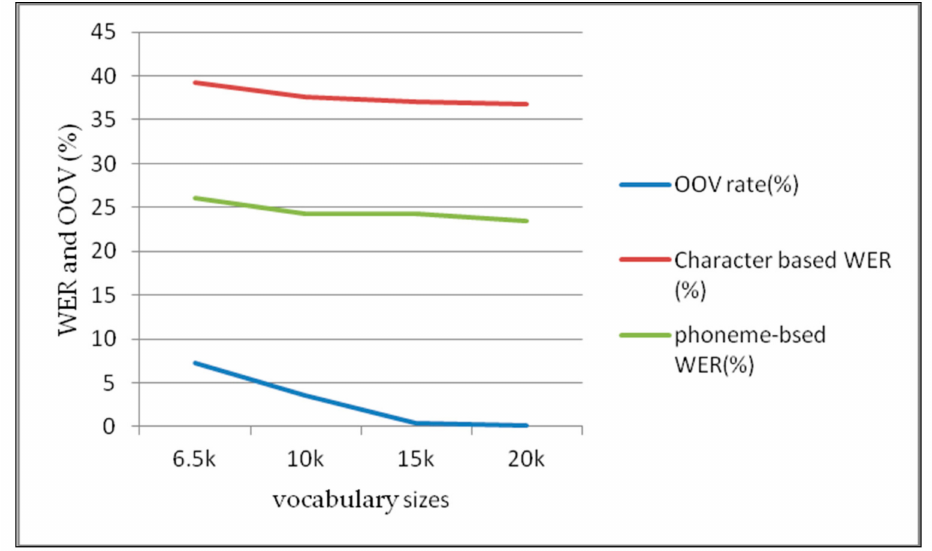
Figure 5. The word error rate (WER) and out‑of‑vocabulary (OOV) percentages in both CTC and